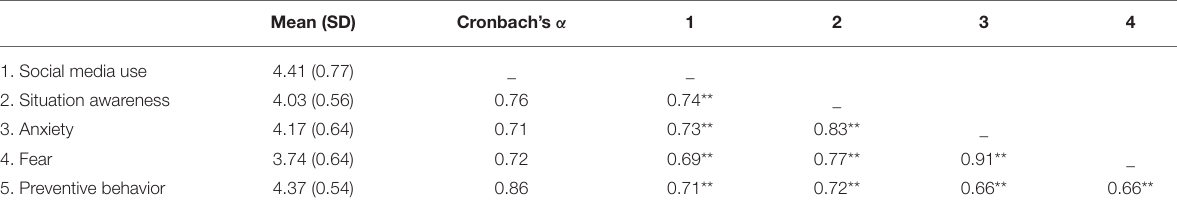
TABLE 1 | Descriptive statistics, inter-correlations and internal consistency of key variables.